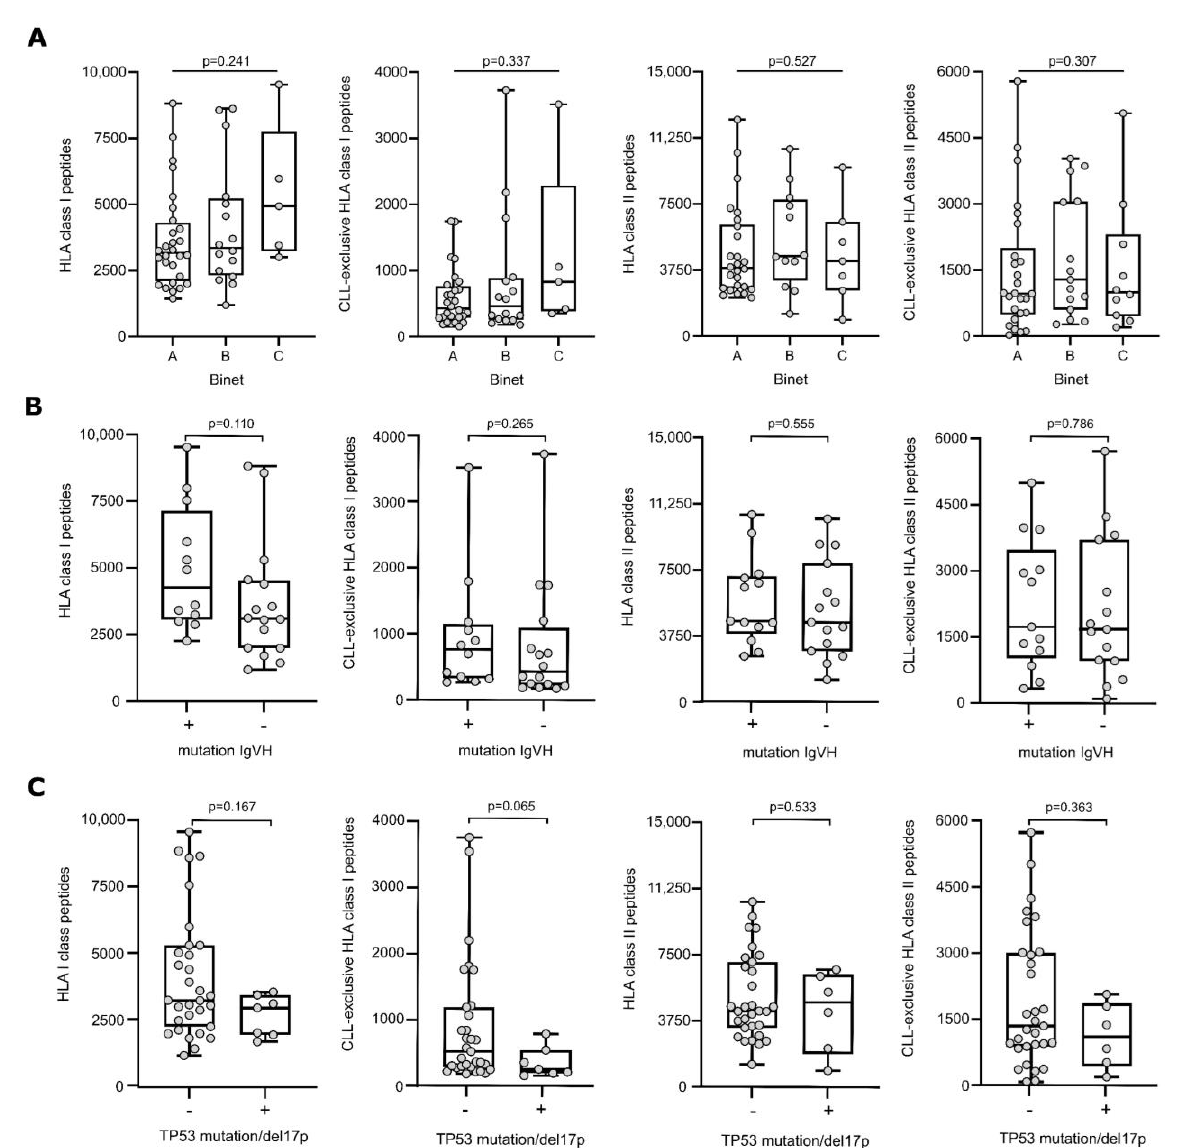
Figure 1. HLA presentation of antigenic peptides according to Binet stage and genetic background. Number of total HLA class I- (left panel), CLL-exclusive HLA class I- (mid-left panel), HLA class II- (mid-right panel), and CLL-exclusive HLA class II-presented (right panel) peptides according to the Binet classification ( A ), the mutational status of IgHV ( B ) and TP53 mutation/del17p ( C ). Dots represent data from individual patients. Boxes represent median and 25th to 75th percentiles with Min/Max whiskers. Brackets mark significant p -values between two categories (Kruskal–Wallis test with Dunn correction), continuous lines indicate non-significant p -values between all categories (Kruskal–Wallis test). Abbreviation: IgHV, immunoglobulin heavy chain variable region; TP53, tumor protein 53; del17p, deletion of the short arm of chromosome 17, p , p -value. The clinical phenotype of the patients was characterized in more detail and the presence of autoimmune phenomena (including autoimmune cytopenia, psoriasis, vasculitis, and sarcoidosis), secondary tumors (including skin, bladder, colon, pancreatic, breast, and prostate cancer) and hypogammaglobulinemia was analyzed in relation to the immunopeptidome data. No difference in terms of total and CLL-exclusive number of peptides presented on CLL cells was observed among patients with or without any of these clinical features (Figure